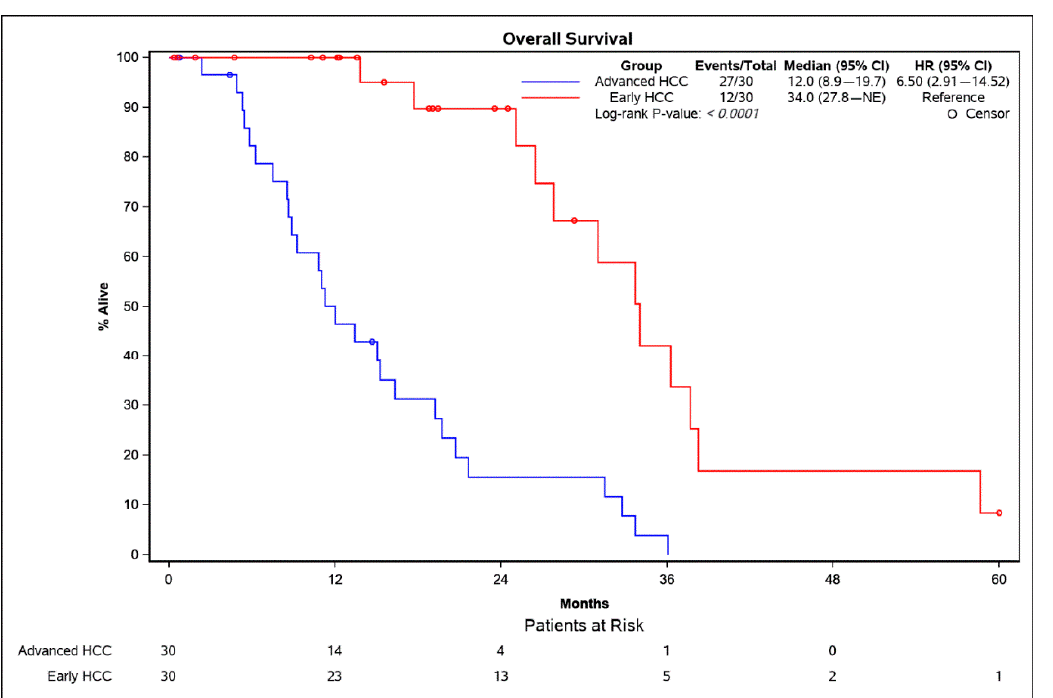
Figure 2. Kaplan–Meier survival analysis of patients with an early HCC (red) and an advanced HCC (blue). The p -value was calculated using the log-rank test. CI = confidence interval; HCC = hepatocellular carcinoma.